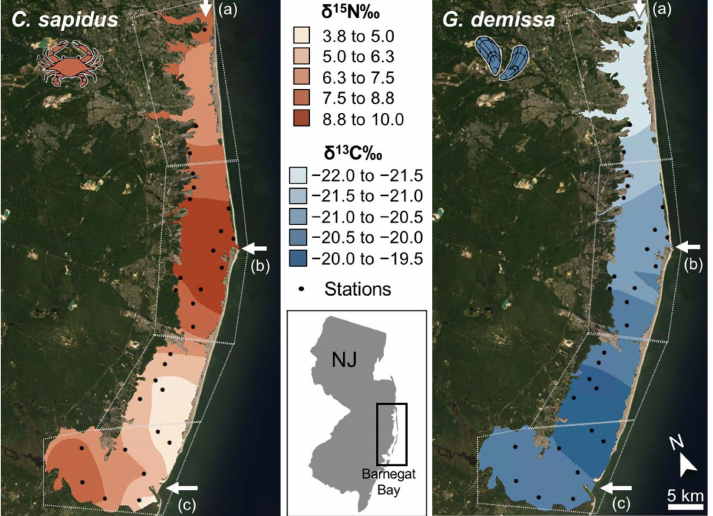
Figure 6. Interpolation maps based on Kriging in ArcGIS including δ 15 N in C. sapidus ( left ); and δ 13 C in G. demissa ( right ). Black points show locations of the 35 stations sampled. The interpolation extent is constrained to water and salt marsh areas around Barnegat Bay. White arrows show current marine inlets ( a ) Point Pleasant Canal; ( b ) Barnegat Inlet; ( c ) Little Egg Inlet. Imagery source: Esri World Imagery acquired in June